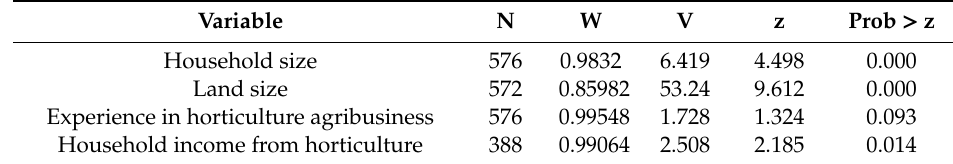
Table 4. Shapiro-Wilk (W) test for normal data distribution.